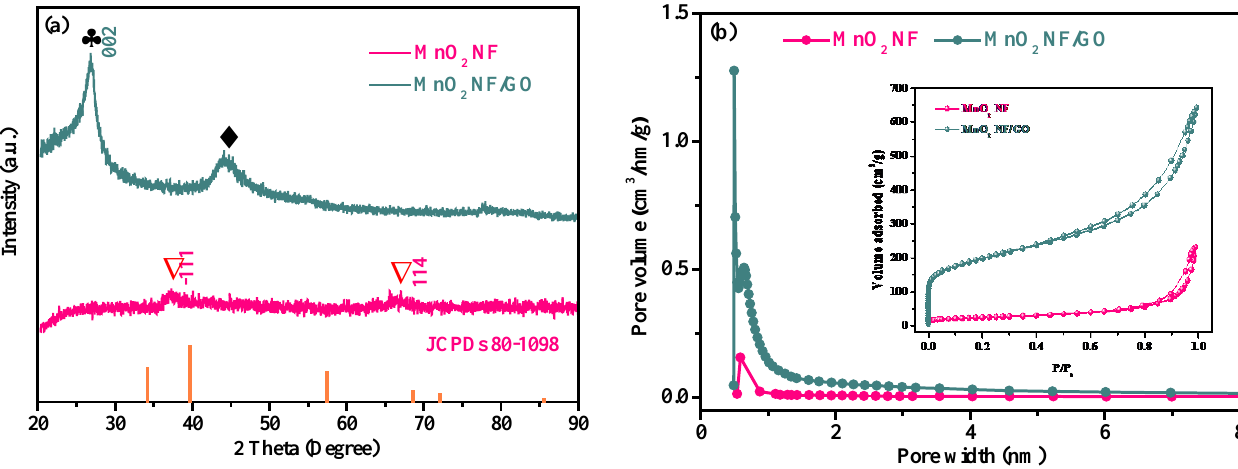
Figure 2. XRD ( a ); the pore size distributions and N 2 adsorption/desorption isotherms ( b ) of as-synthesized composites.